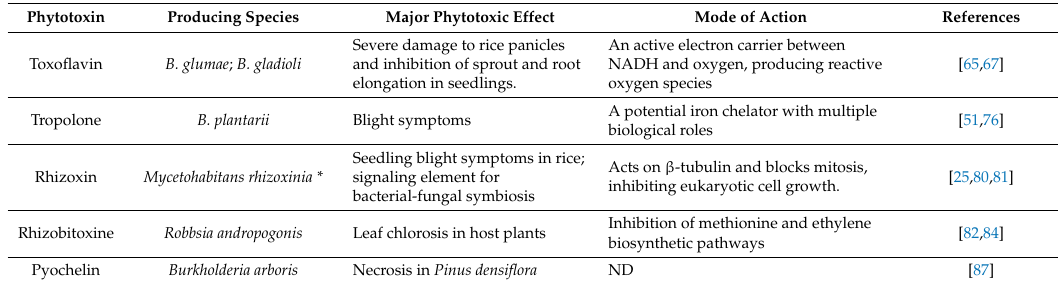
Table 2. Phytotoxins produced by phytopathogenic Burkholderia species, their major phytotoxic effect, and mode of